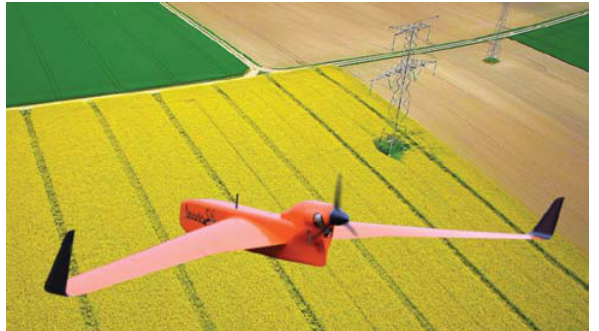
Figure 2. The Boréal